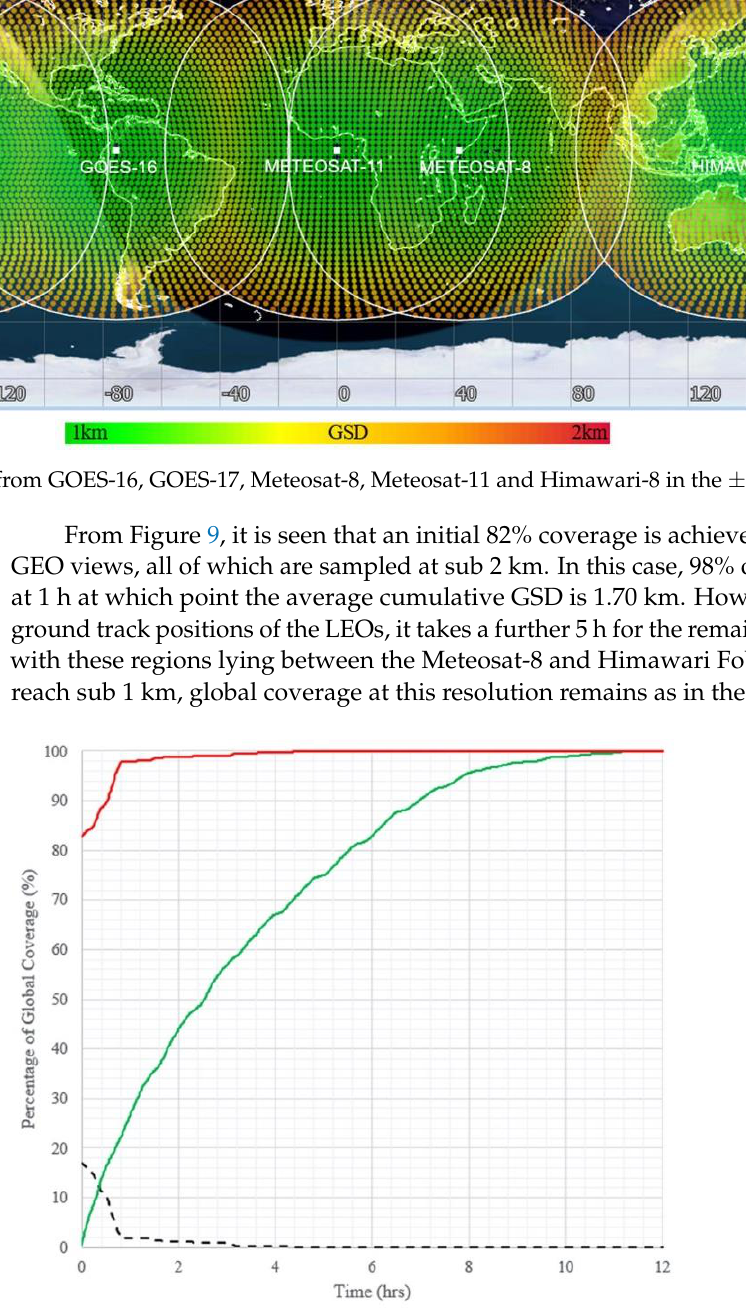
Figure 9. Cumulative global coverage from combined LEO and GEO instruments.